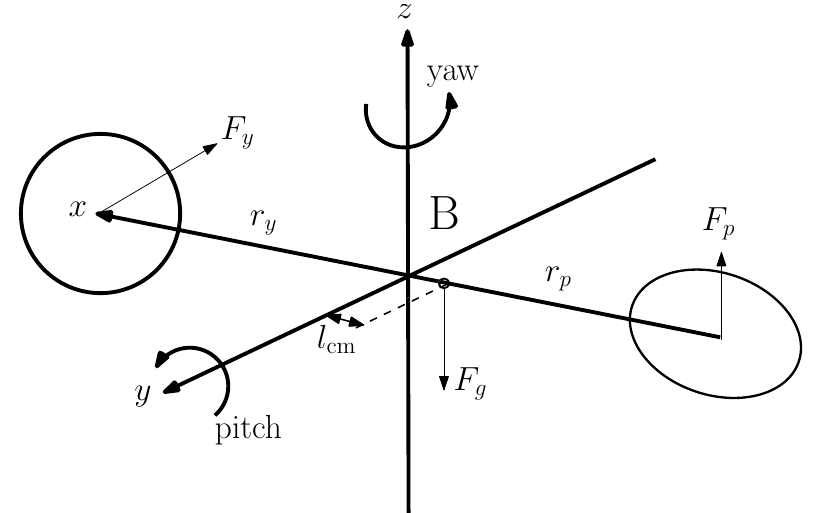
Figure 1. Schematic representation of the Quanser 2-DOF AERO